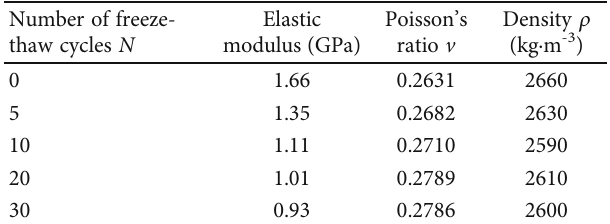
Table 3: Physical parameters of sandstone under di ff erent freeze- thaw cycles.